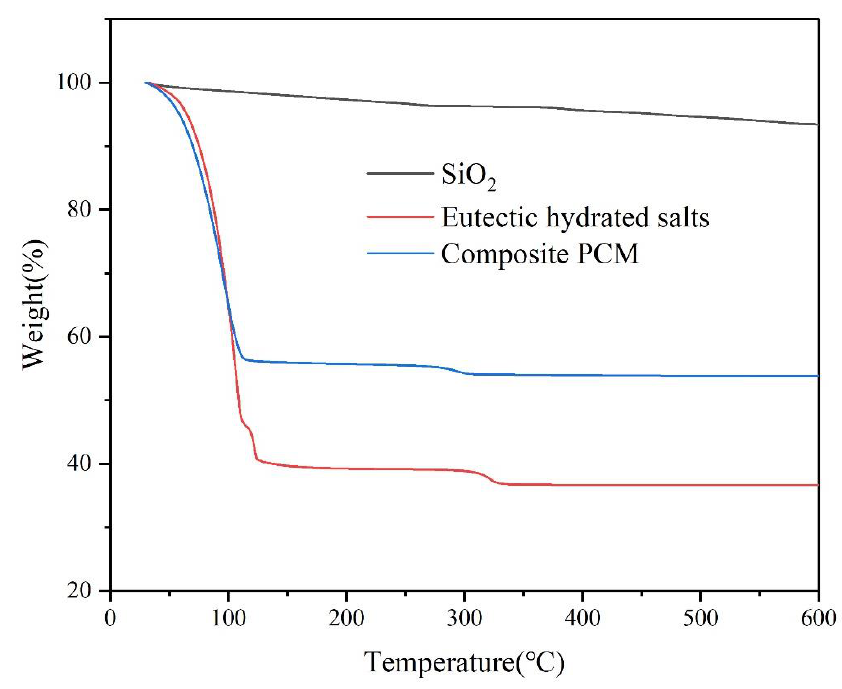
Figure 7. TGA curves of SiO 2 , eutectic hydrated salts, and composite PCMs.